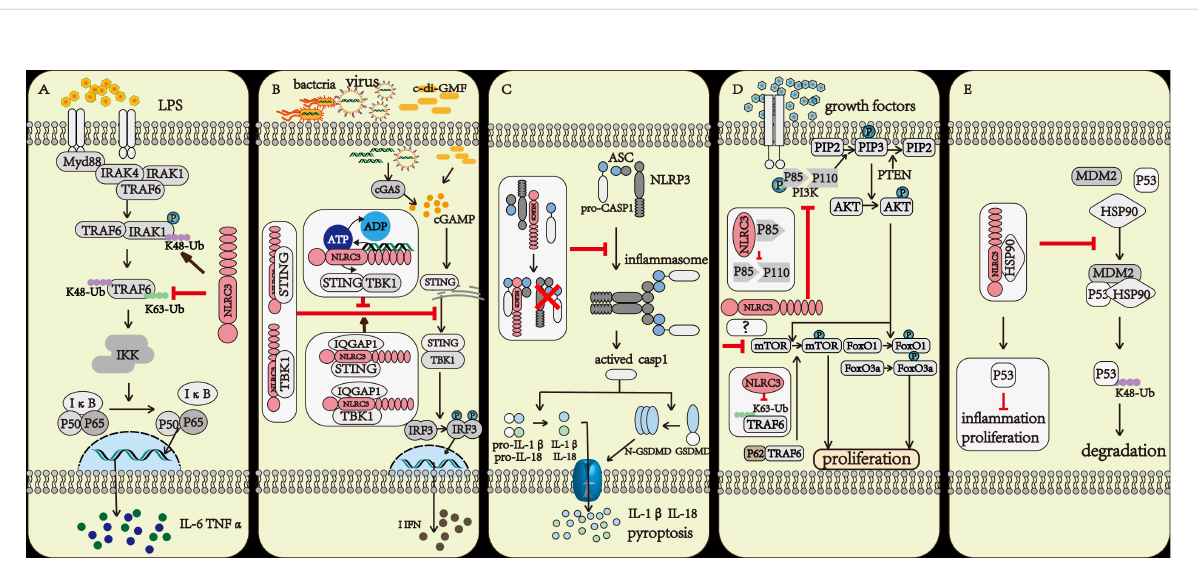
FIGURE 2 The regulatory mechanism of NLRC3. (A) The TRAF6 and IRAK1 activation upon LPS stimulation further activate the NF- k B signaling pathway. NLRC3 prevents the K63-linked polyubiquitination of TRAF6 and promotes the degradation of TRAF6 through proteasome, or NLRC3 promotes the K48-linked polyubiquitination of IRAK1 and promotes the degradation of IRAK1 through proteasome. (B) Upon the Bacteria, Virus infection and c-di-GMF stimulation, the DNA binding to LRR domain of NLRC3 increased the activation of ATPase on the NBD domain of NLRC3, prevented the association of NLRC3 and STING and inhibited the STING/TBK1 signaling pathway. IQGAP1 interacted with NLRC3, promoted NLRC3 to bind with STING and TBK1, and further enhanced the inhibitory effect of NLRC3 on STING/TBK1 signaling pathway. All further attenuates the production of type I interferon (I-IFN), preventing the in fl ammatory response of macrophages. (C) NLRC3 interacts with ASC and pro-CASP1 through the NBD domain, then prevents the formation of the in fl ammasome, and makes cells stay away from pyroptosis. (D) NLRC3 interacts with the p85 subunit of PI3K, then inhibits the interaction of p85 submit and catalytic submit p110 a , preventing the phosphorylation and activation of the p110 a submit, which blocks the transmission of downstream signals, including PI3K-AKT-mTOR and PI3K-AKT-FoxO3a/ FoxO1 signaling pathways; P62 interacting with TRAF6 induced the activation of mTOR, NLRC3 prevents the K63-linked polyubiquitination of TRAF6, and negatively regulates the mTOR signaling pathway and prevents cell proliferation. (E) NLRC3 interacts with HSP90 to inhibit HSP90- mediated ubiquitination of P53 and inhibit the degradation of P53 in